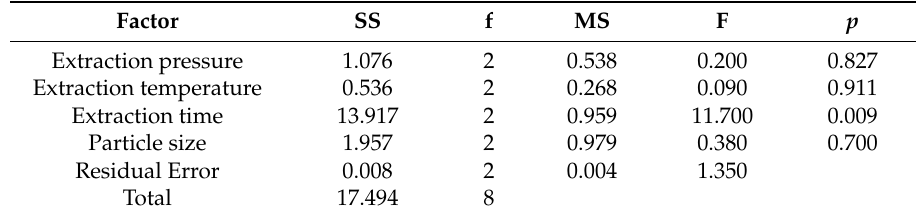
Table 2. Analysis of variance (ANOVA) of the EDS oil extraction.